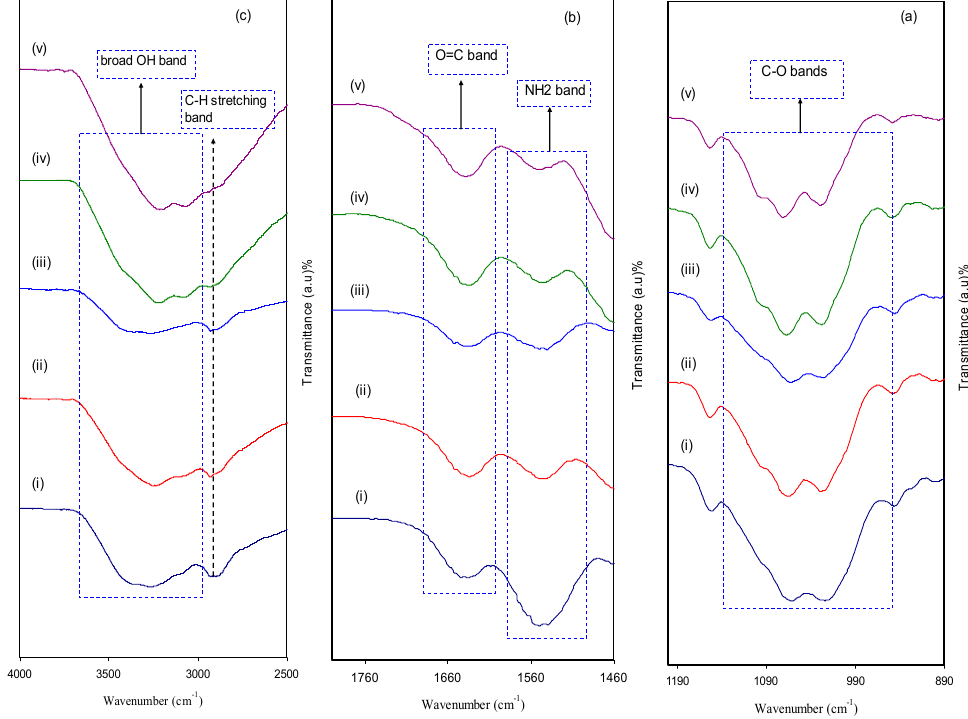
Figure 4. FTIR spectrum of ( i ) CMCF0, ( ii ) CMCF1, ( iii ) CMCF2, ( iv ) CMCF3 and ( v ) CMCF4 in the range ( a ) 890 cm − 1 to 1190 cm − 1 , ( b ) 1460 cm − 1 to 1760 cm − 1 and ( c ) 2500 cm − 1 to 4000 cm − 1 .